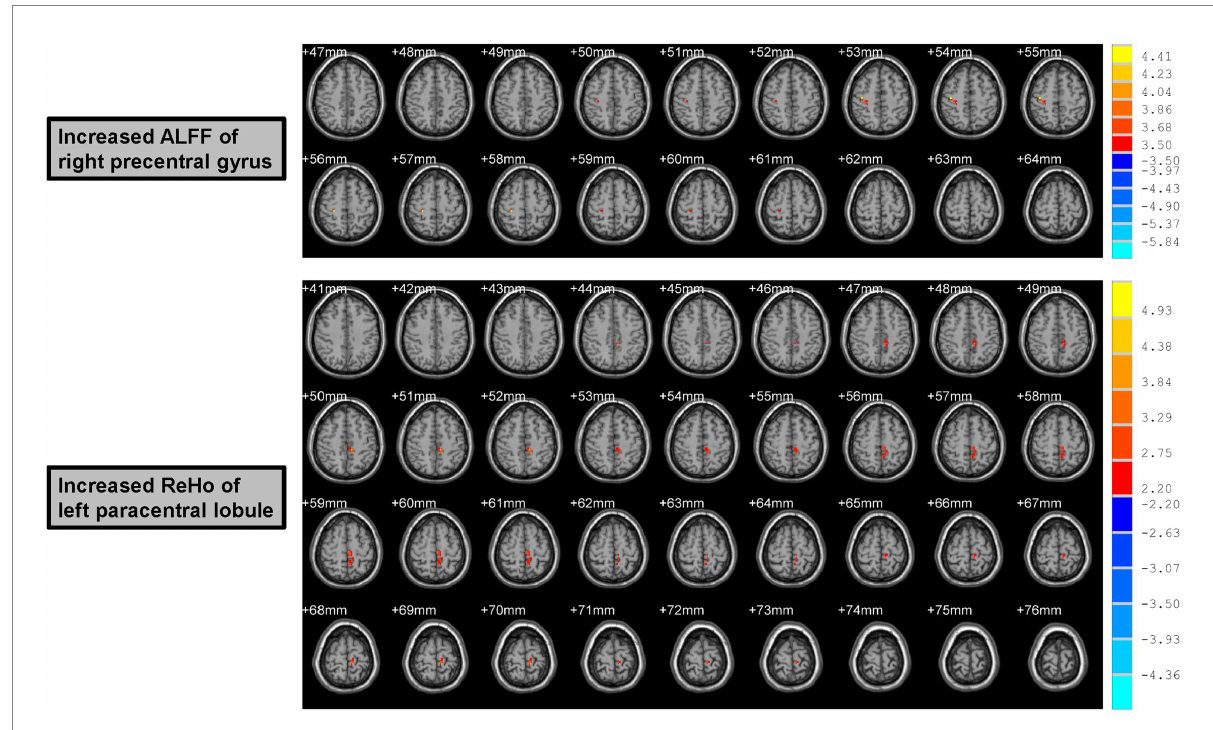
FIGURE 2 Increased ALFF and ReHo values of male rowing athletes after tDCS. ALFF, amplitude of low-frequency fluctuation; ReHo, regional homogeneity. tDCS, transcranial direct current stimulation. AAL, anatomic automatic labeling; MNI, Montreal Neurological Institute; x , y , and z : the coordinates of peak voxel of each cluster in the MNI space. For the measure of ALFF, the significant differences were set at p < 0.005 (a minimum cluster size of 12 voxels, corrected by the AlphaSim program in REST software). For the measure of ReHo, the significant differences were set at p < 0.05 (a minimum cluster size of 54 voxels, corrected by the AlphaSim program in REST software).